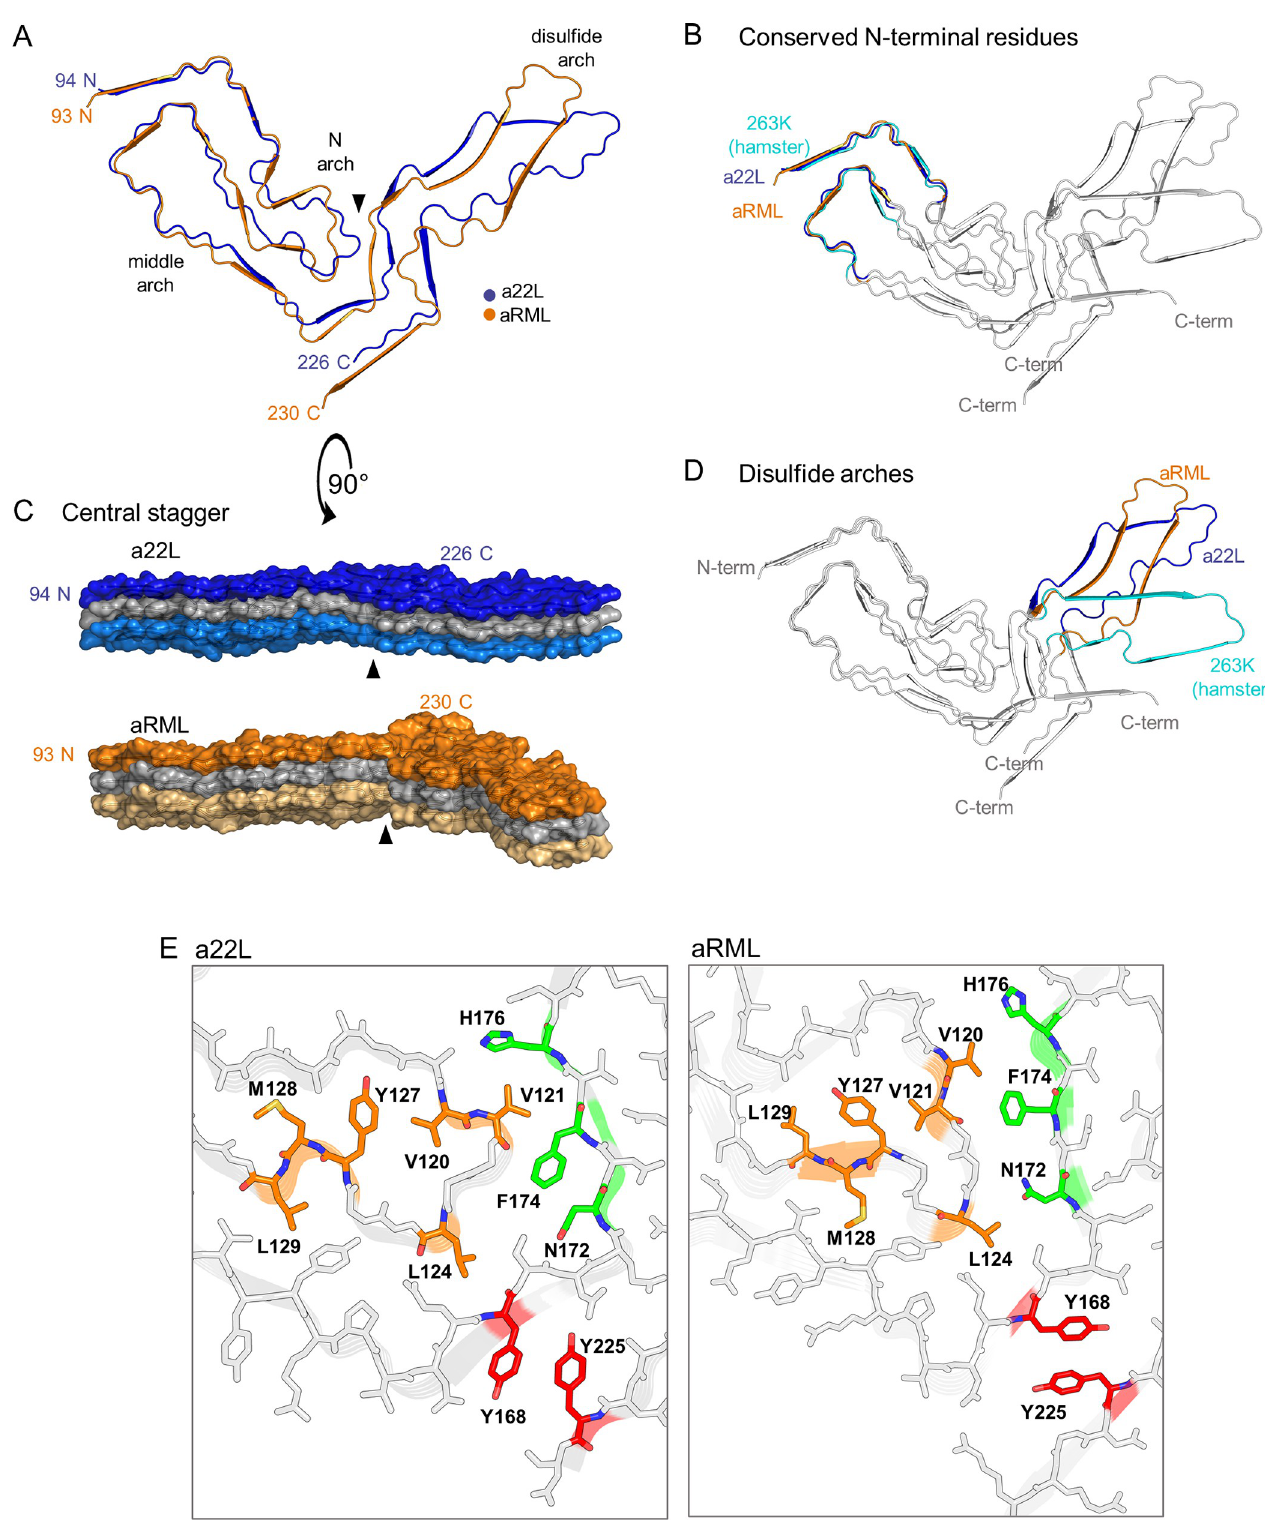
Fig 5. Comparison of a22L and aRML prions. (A) Overlay of cross-sections of a22L and aRML cores. (B) Overlay of a22L, aRML and 263K cross-sections, highlighting conformationally conserved N- terminal region. (C) Lateral views of a22L and aRML EM maps (stacks of 3). Arrowheads indicate interface between the head of the N arch and the central strand between the N- and C-terminal lobes of a given monomer, where less axial stagger is seen in a22L than